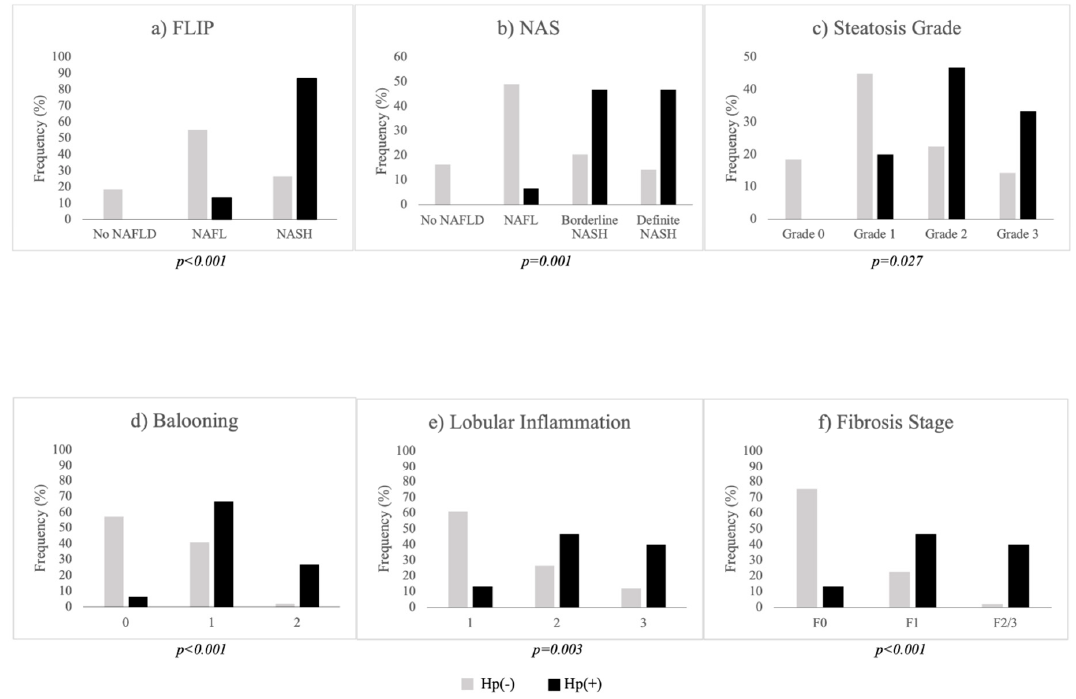
Figure 1. Bar grams depicting the histological endpoints: ( a ) FLIP; ( b ) NAS; ( c ) steatosis grade; ( d ) ballooning; ( e ) lobular inflammation; ( f ) fibrosis stage. The rates of Hp infection were increased with the severity of all presenting histological lesions and composite scores (FLIP and NAS). Hp ( + ): Black bars; Hp ( − ): Grey bars. Abbreviations: F: Fibrosis stage; FLIP: Fatty liver inhibition of progression; Hp ( + ): Helicobacter pylori positive; Hp ( − ): Helicobacter pylori negative; NAFLD: Nonalcoholic fatty liver disease; NAS: Nonalcoholic fatty liver disease activity score; NASH: Nonalcoholic steatohepatitis.